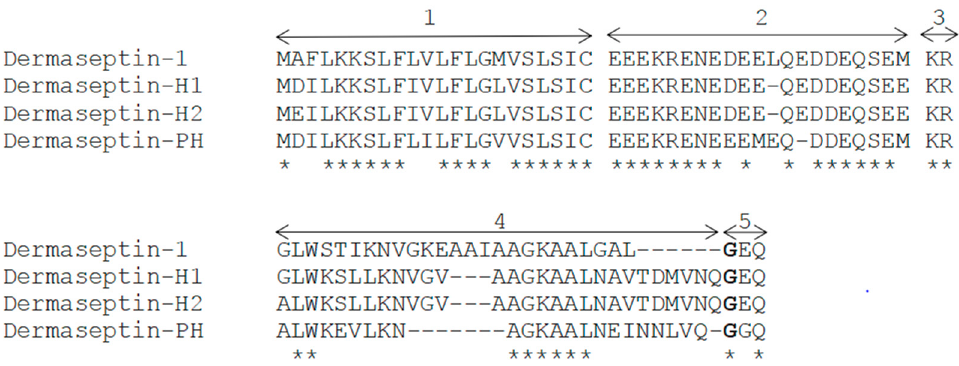
Figure 2. Alignments of the amino acid sequences of the prepropeptides of Dermaseptin-1, Dermaseptin-H1, Dermaseptin-H2, and Dermaseptin-PH comprise five domains, 1: putative N-terminal signal peptide region; 2: acidic amino acid rich spacer peptide region; 3: endoproteolytic cleavage point; 4: mature peptide progenitor region; 5: extension of biosynthetic precursor. Amino acid indicated with bold type serves as an amide donor for C-terminal amidation. The identical amino acid residues are indicated by the asterisks.